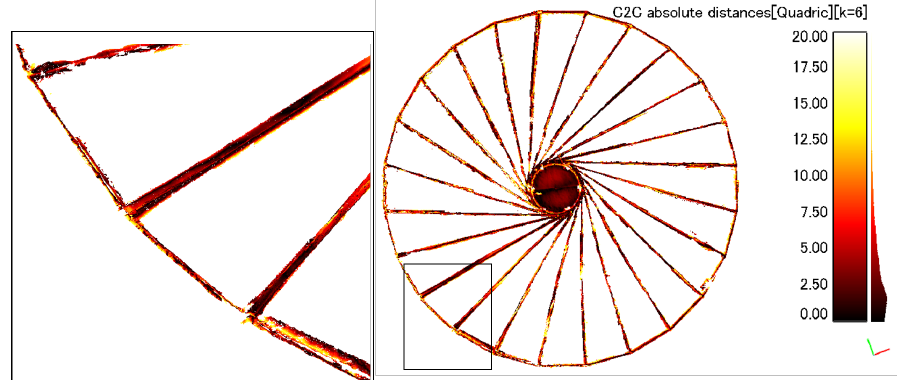
Figure 9. Computed cloud-to-cloud (C2C) absolute distances in millimetres between reflector model and scanned areas of reflector ribs, rims and center